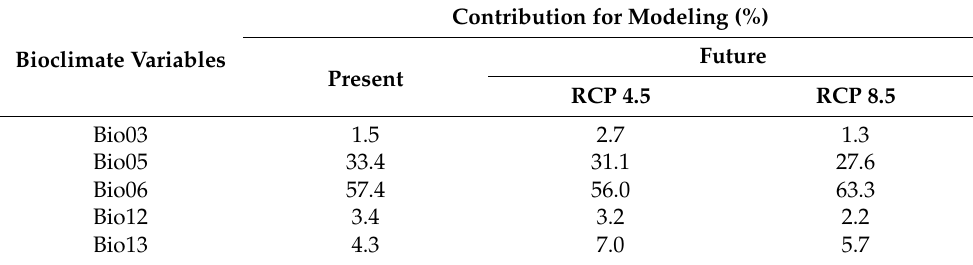
Table 2. The percentage of contribution for species distribution modeling on Lithobates catesbeianus introduced in South Korea. Present: 1960–1990, Future: 2070 (2061–2080) (Hijmans et al. 2005) [37].